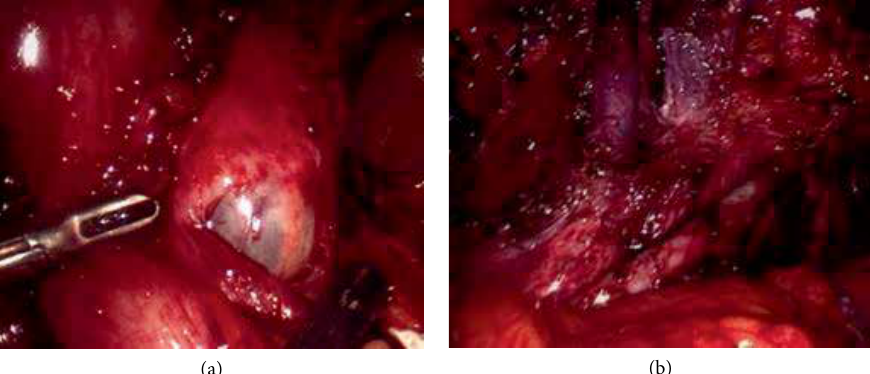
Figure 1: Intraoperative images: (a) left pelvic cyst (a 4 cm ovarian remnant cyst) was identified and the entire ovary was removed; (b) endometriotic nodules and endometriosis on left external iliac artery and